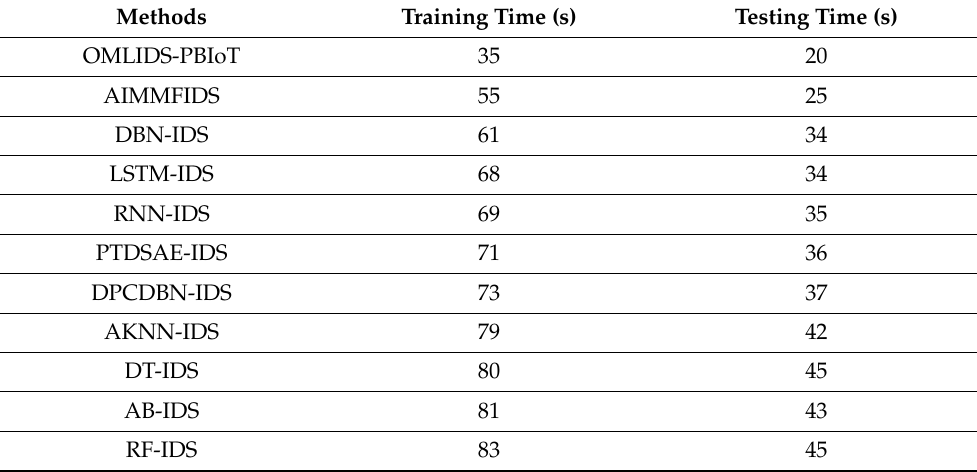
Table 5. TRT and TST analysis of OMLIDS-PBIoT technique with existing